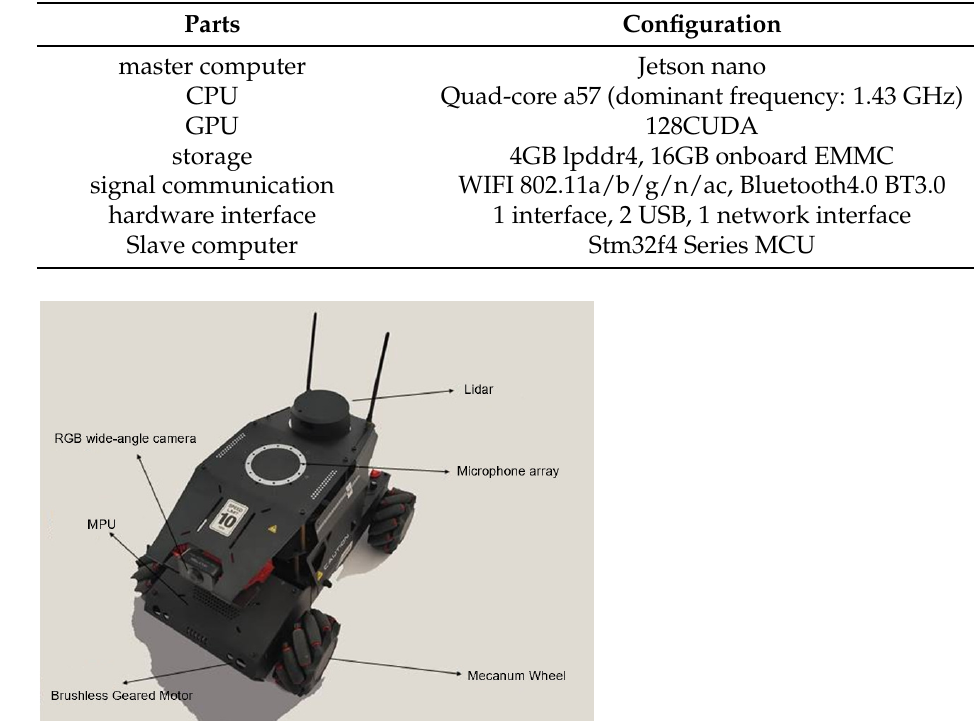
Table 1. Overall hardware composition.